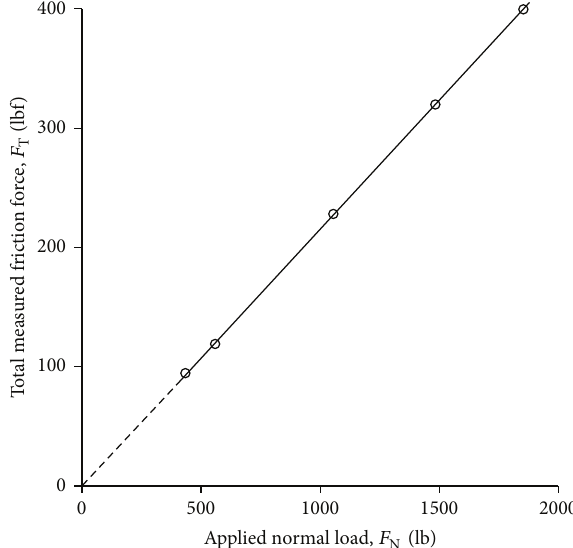
Figure 7: Results of CFME testing [8] on an ungrooved concrete runway taxiway at 17 percent tire slip in dry conditions illus- trating the inability to generate the microhysteretic friction force (reproduced with permission from the International Journal of Pavements © ,